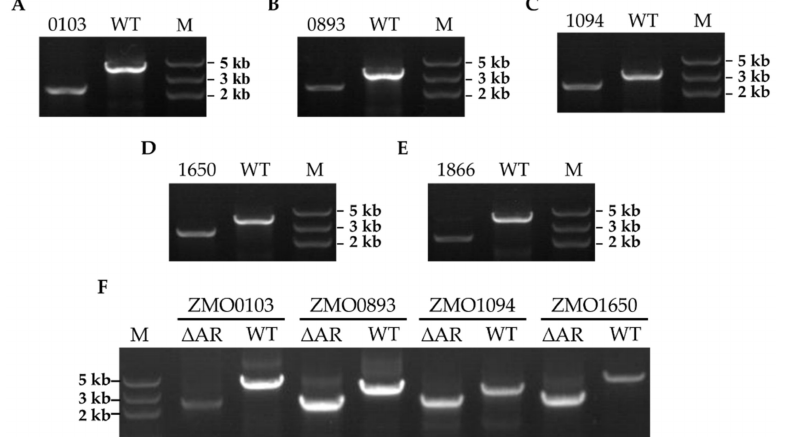
Figure 1. Confirmation of ampicillin − resistant (AR) knockout strains in Z. mobilis ZM4 by PCR. The mutants of ZM4 ∆ 0103 ( A ), ZM4 ∆ 0893 ( B ), ZM4 ∆ 1650 ( C ), ZM4 ∆ 1094 ( D ), ZM4 ∆ 1866 ( E ), and ZM4 ∆ ARs ( F ) were confirmed by colony PCR using their corresponding primers. The sizes of PCR products (bp) of WT and knockout strains were 4021, 2247 (ZM4 ∆ 0103); 3314, 2232 (ZM4 ∆ 0893); 3122, 2361 (ZM4 ∆ 1650); 3746, 2221 (ZM4 ∆ 1094); 3768, 2080 (ZM4 ∆